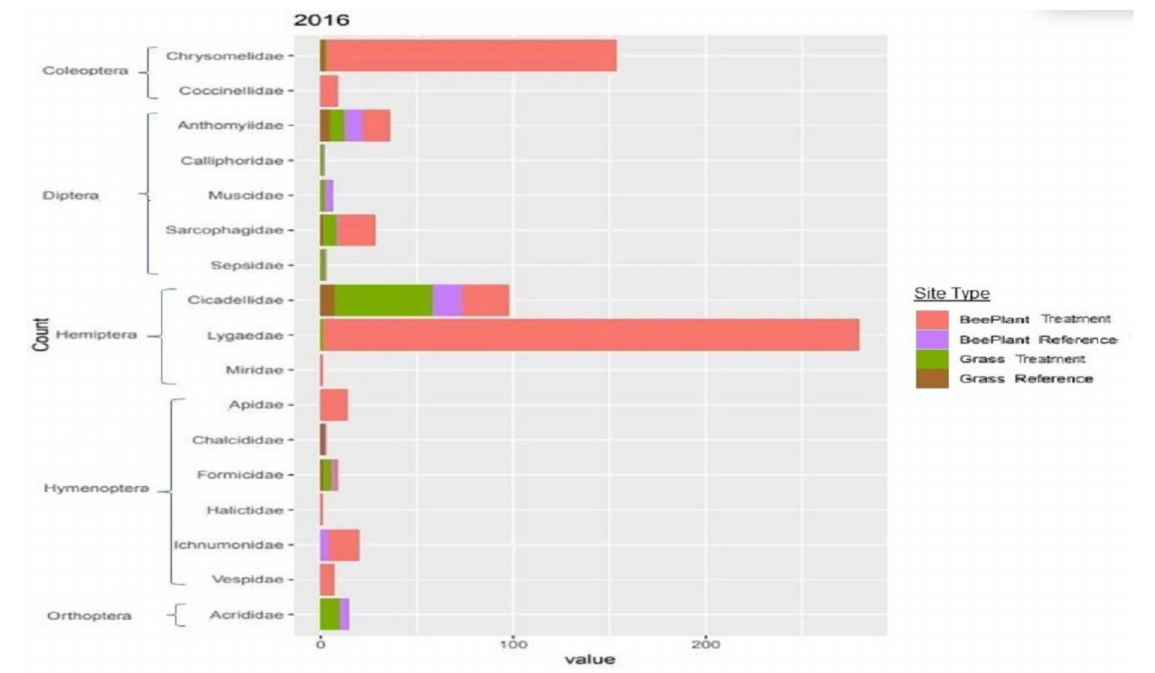
Figure 5. A stacked bar chart of insect abundance by family found on each site type in